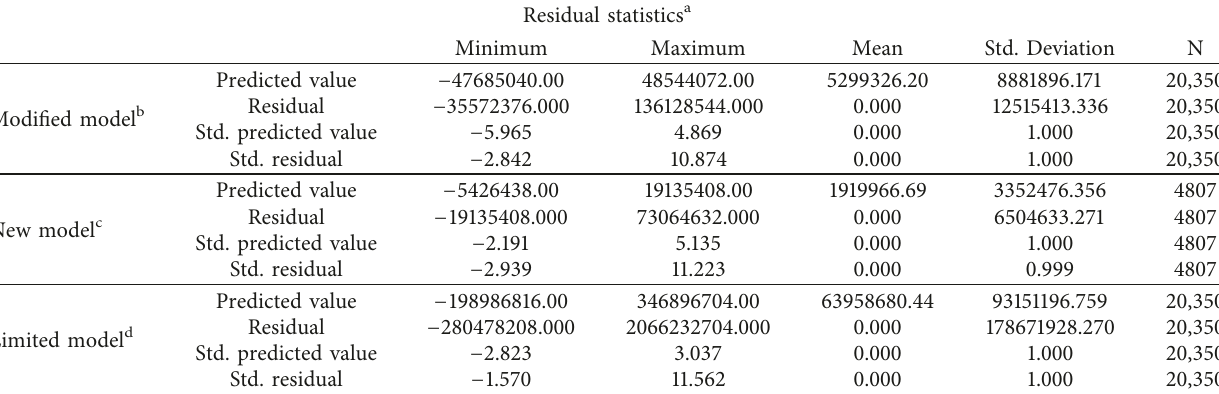
Table 24: Residual statistics for a DOE large office building depending on different models.